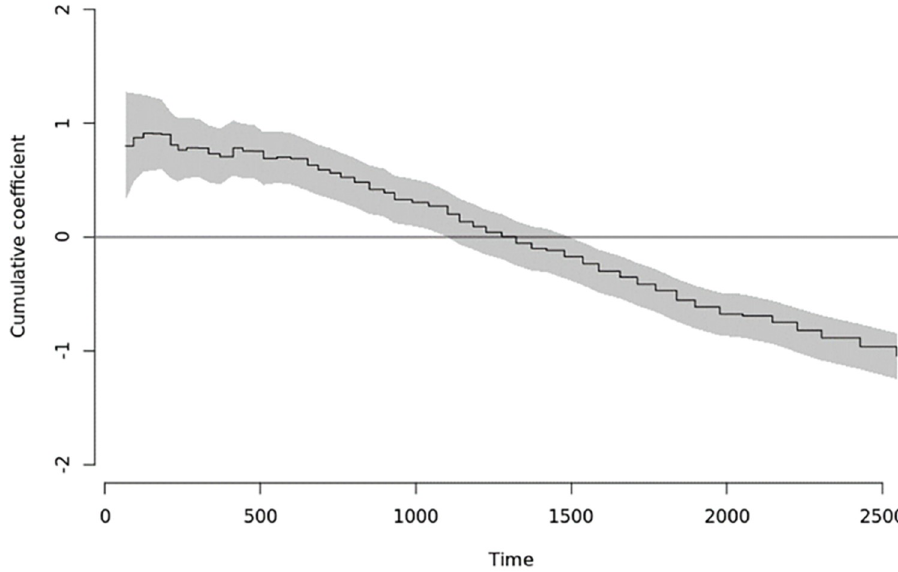
Fig 4. Time-varying effect of anti-coagulation regime on sub-distribution hazards for all-cause